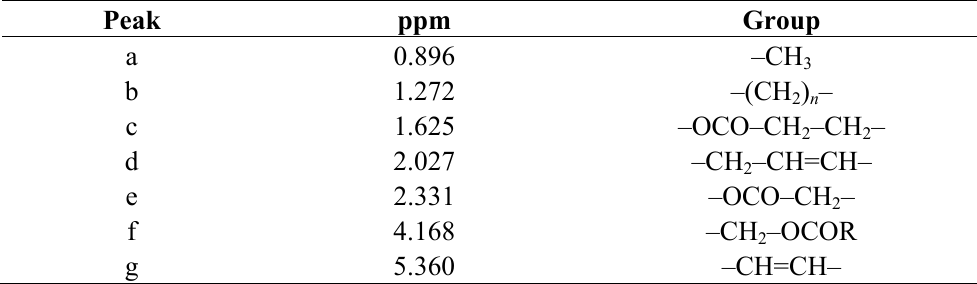
Table 2. Assigments of 1 H NMR chemical shifts according to Guillén and Ruiz